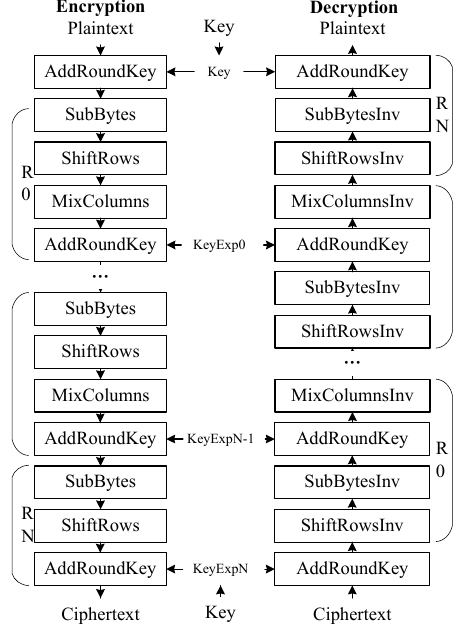
Figure 1. AES-128 encryption and decryption process.